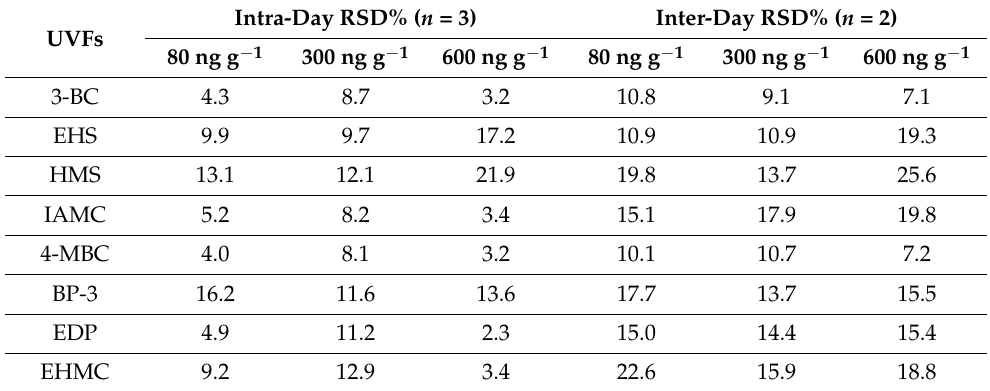
Table 4. Intra-day ( n = 3) and inter-day ( n = 2) relative standard deviations (RSD%) calculated for the UVFs.